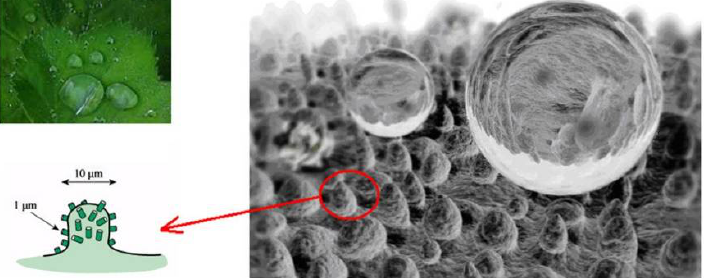
Figure 3. Superhydrophobicity and the multiscale structural surface of Lotus leaf. Reprinted with permission from Ref [44]. Copyright 2011 Elsevier.